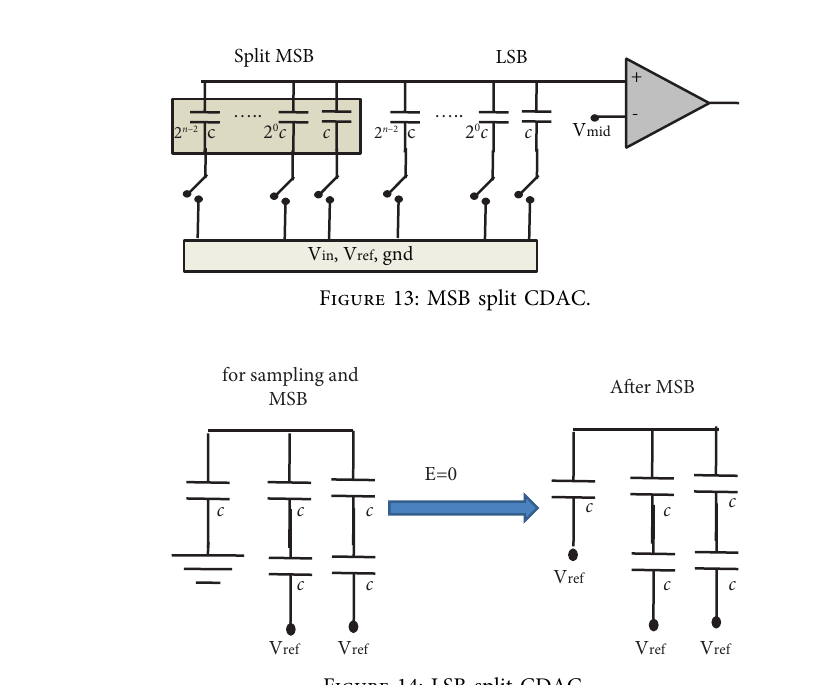
Figure 12: Te merge-split CDAC technique [35].